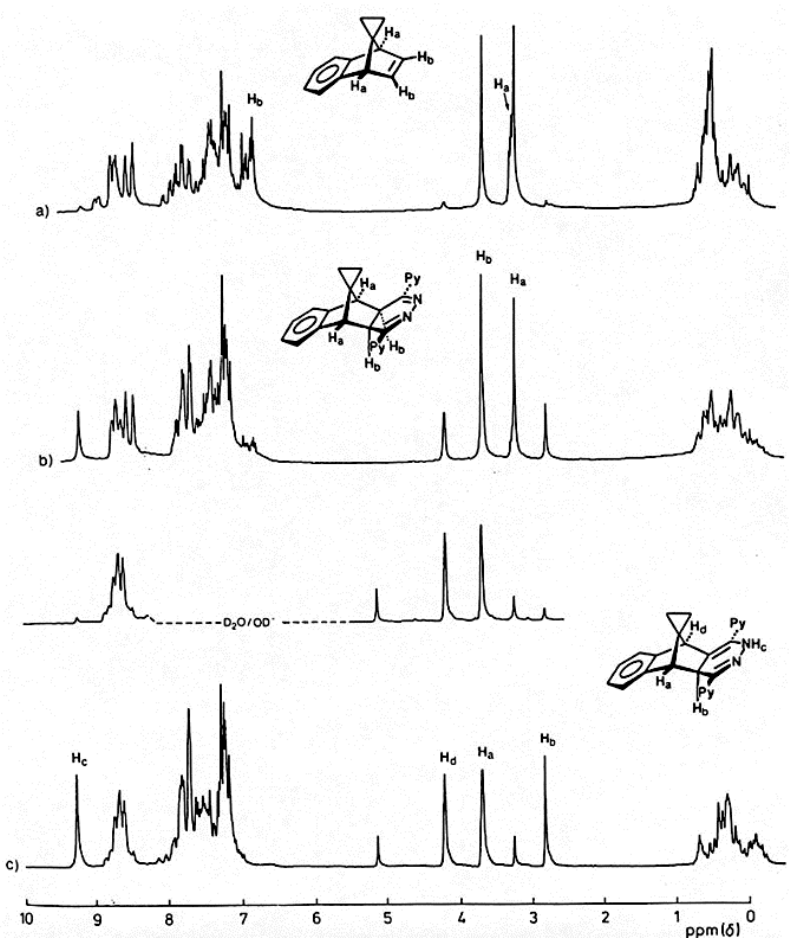
Figure 3. 1 H-NMR spectra (80 ) of products resulting MHz; CDCl 3 from the reaction between s - tetrazine 2 and 7-spirocyclo- propylbenzonorbornadiene 23 after (a) 30 min at 30 o C ; (b) 120 min at 30 o C; (c) 24 hours at 60 o